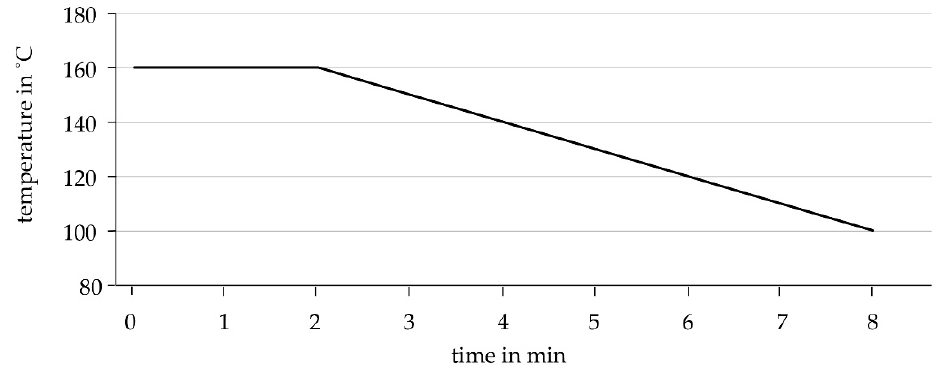
Figure 6. Temperature curve in pressing cycle at constant pressure of 1.3 bar.